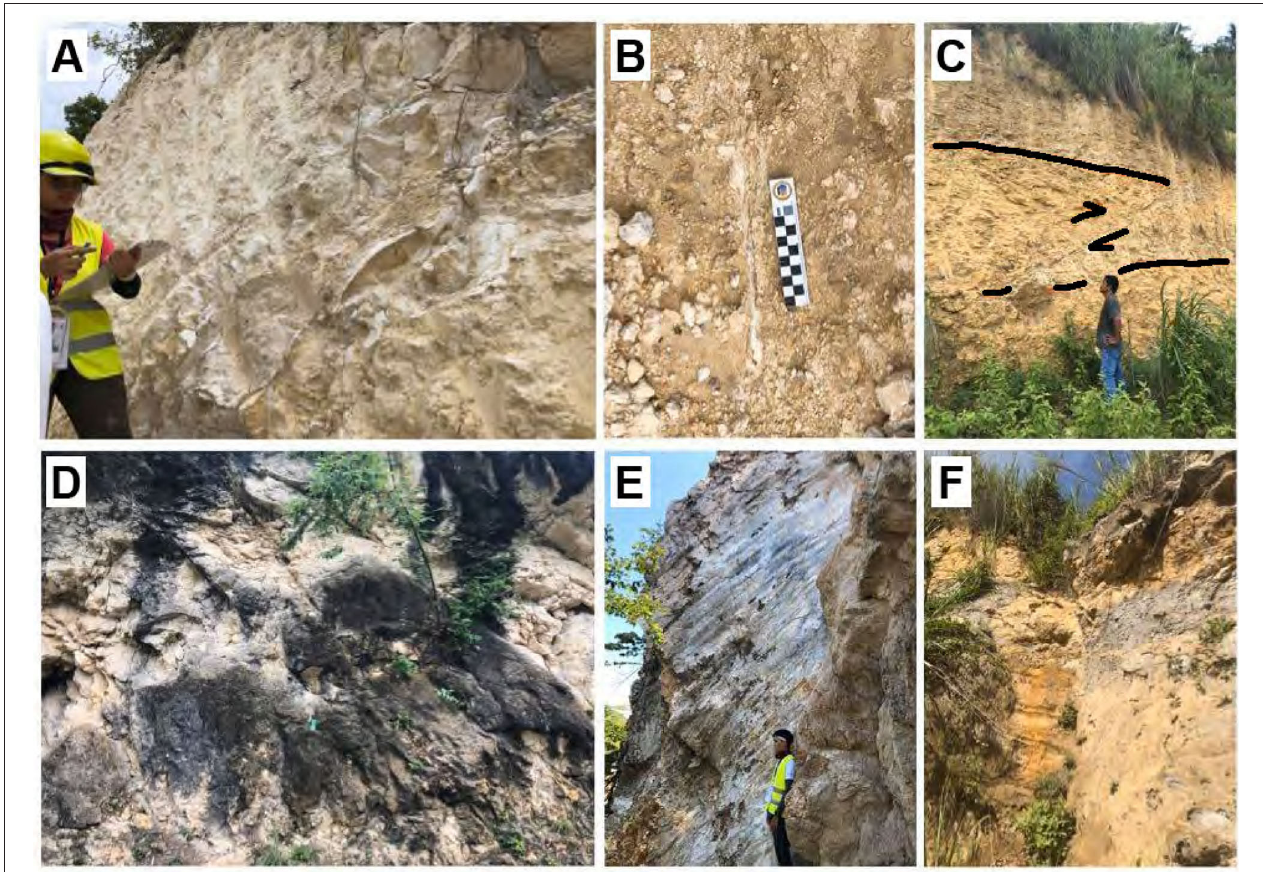
FIGURE 10 | (A–C) Faults at the margins of the headscarp. (D–F) Faults in areas farther from the landslide (please see Figure 11